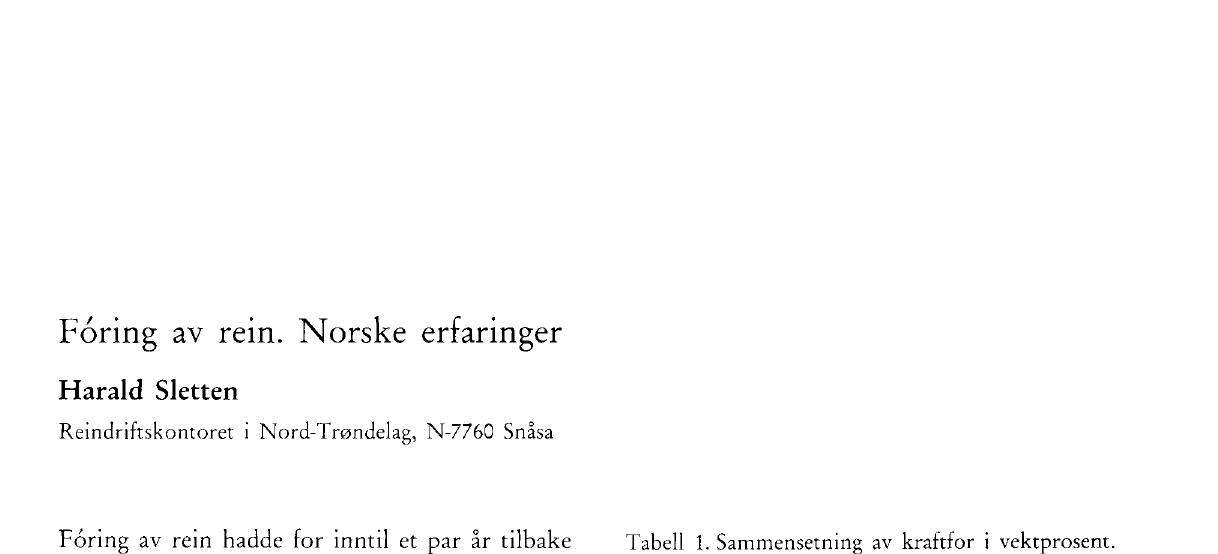
Tabell 1. Sammensetning av kraftfor i